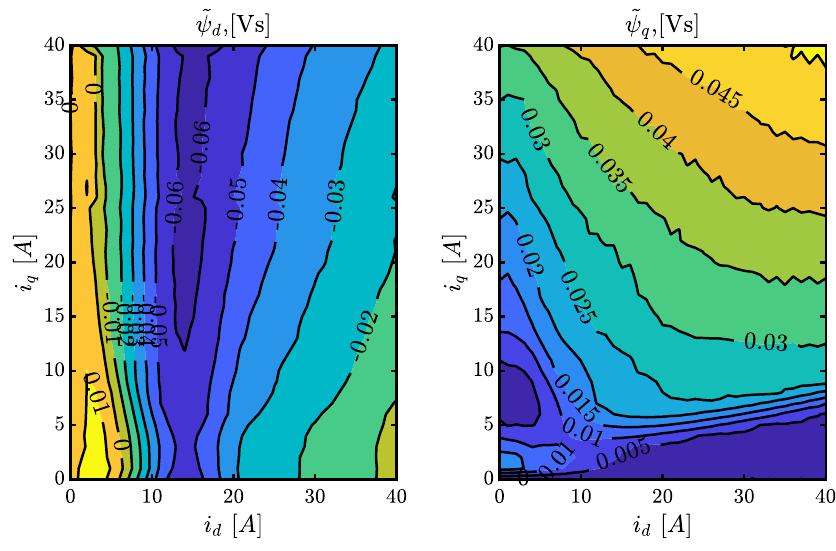
Figure 9. Discrepancy of the flux maps: d -axis ( left ) and q -axis ( right ). As can be observed, the maximum flux errors are 0.06 Vs and 0.045 Vs for the d - and q -axes, respectively.